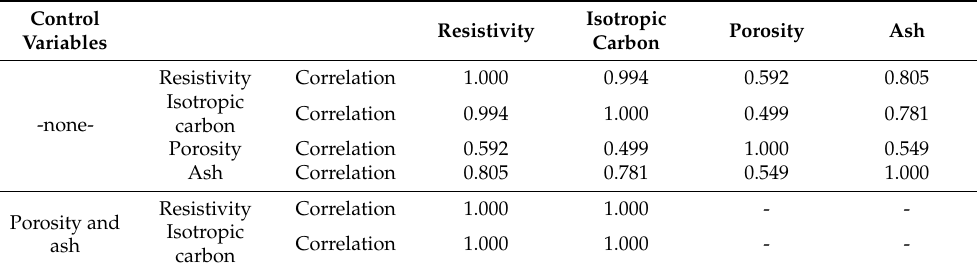
Table 6. Correlation matrix of percentage isotropic carbon and coke resistivity while controlling for ash content and